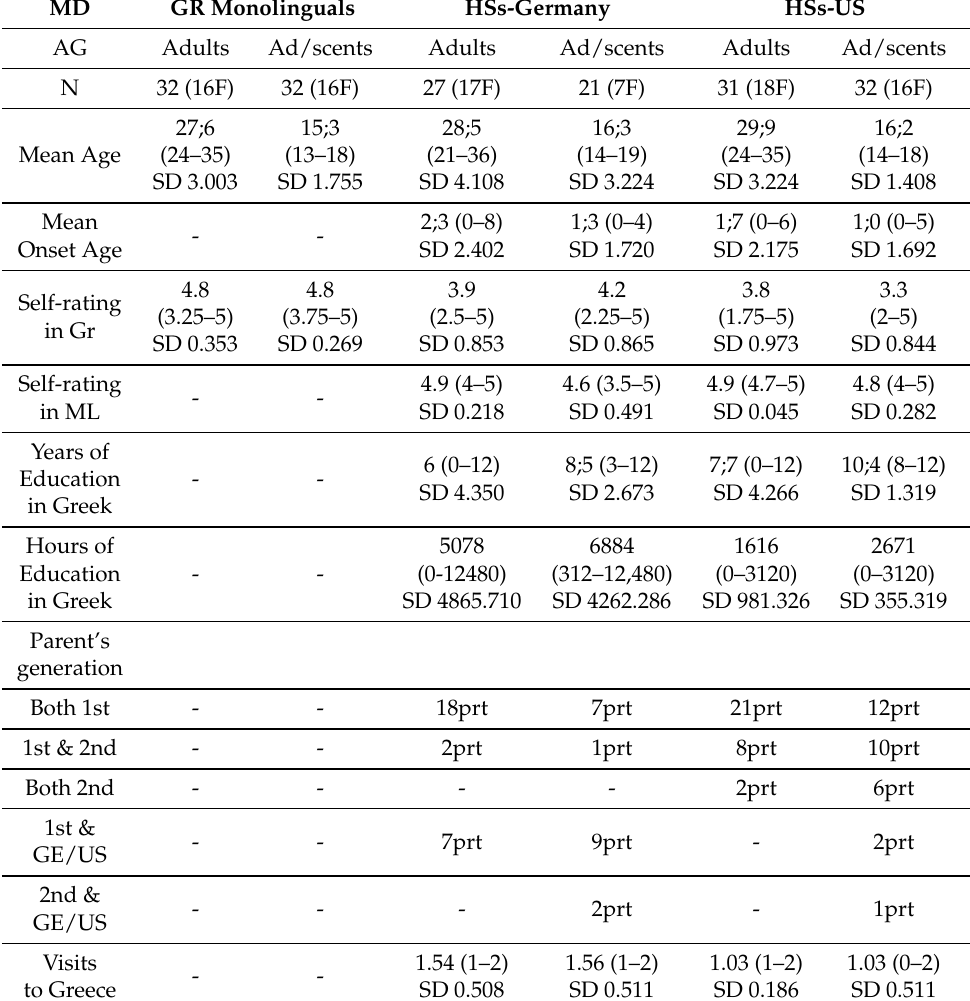
Table 1. Metalinguistic data across language and age groups.